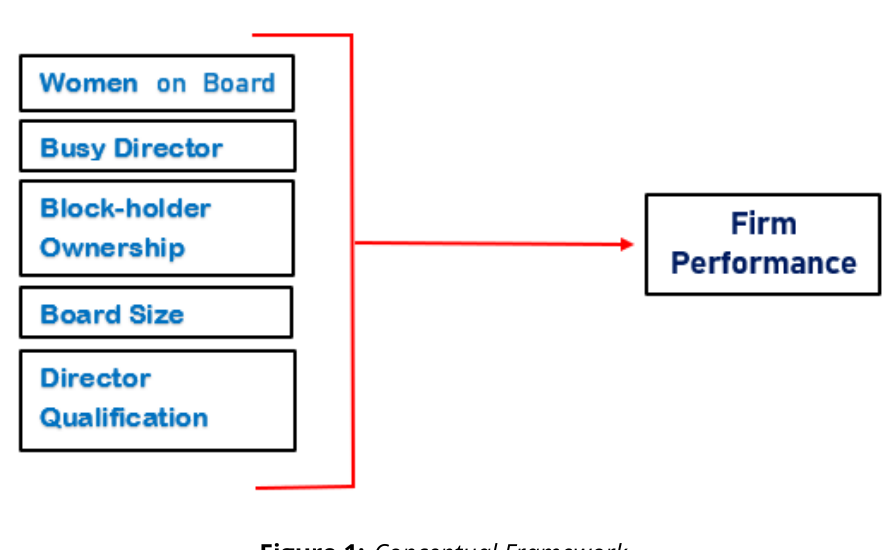
Figure 1: Conceptual